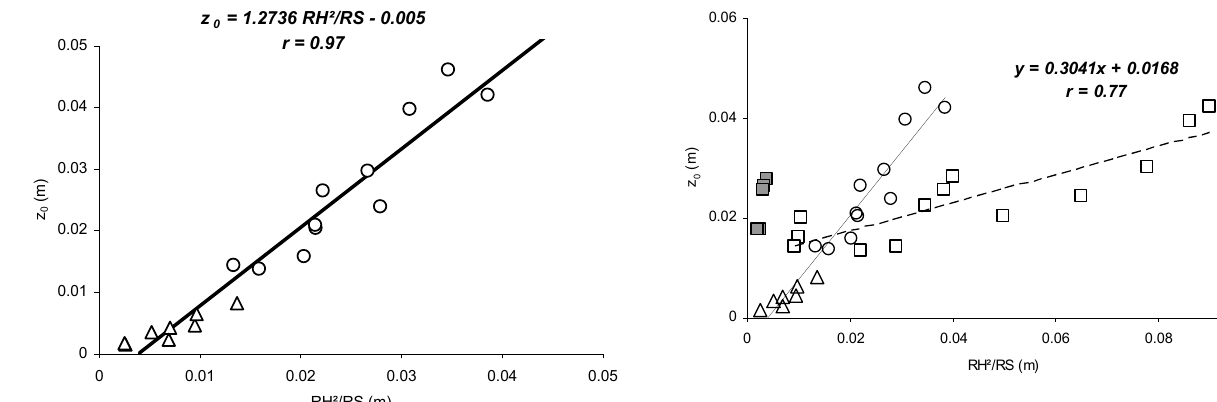
Fig. 4. Aerodynamic roughness length ( z 0 ) as a function of RH 2 /RS ( RH , ridge height; RS , ridge spacing). Circles: this study; triangles: Hagen and Armbrust (1992); squares: Saleh et al. (1997). The solid line represents the relation for ridges with a little random roughness and the dashed line represents ridges with random roughness caused by clods. RH 2 /RS ratios for data from Saleh et al. (1997) have been corrected to account for the rotation coefficient when ridges were not perpendicular to the wind direction. Note that the relation- ship from data by Saleh et al. (1997) does not account for the grey squares which correspond to the moldboard plow.